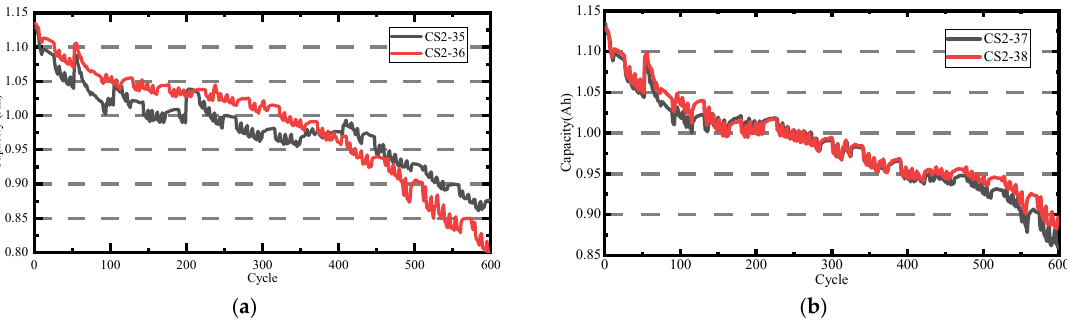
Figure 1. Battery capacity degradation curve. ( a ) CS2–35 and CS2–36 capacity degradation curves; ( b ) CS2–37 and CS2–38 capacity degradation curves.